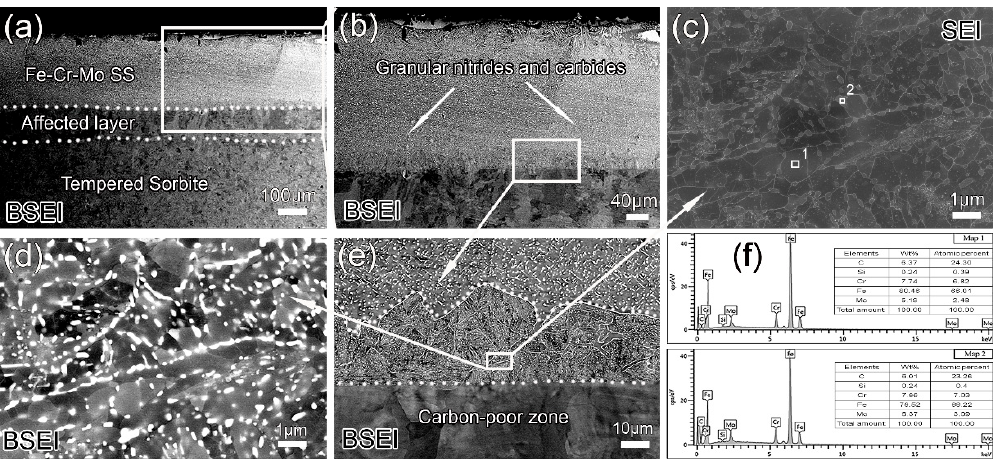
Figure 4. BSEI images, secondary electron imaging (SEI) images, and EDS patterns of the CrMo-6-QT sample: ( a ) cross-sectional view; ( b ) partially enlarged view; ( c ) and ( d ) are enlarged views of the white boxes in ( e ); ( e ) is an enlarged view of the white box in ( b ); ( f ) EDS patterns of the points in ( c ).